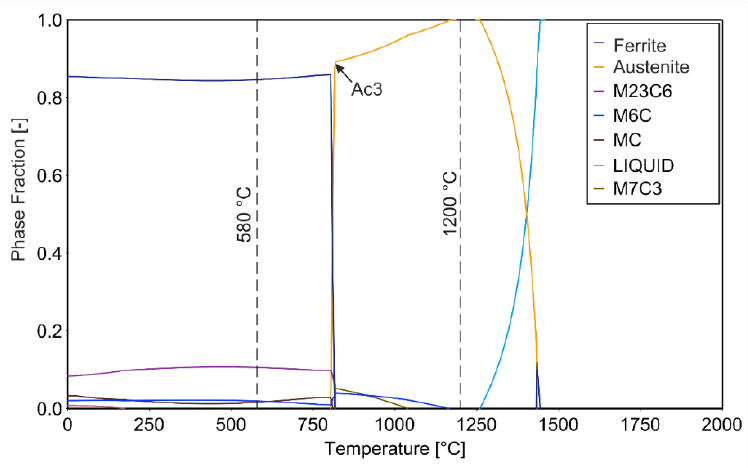
Figure 1. Calculated equilibrium phase fraction of the M50 powder.